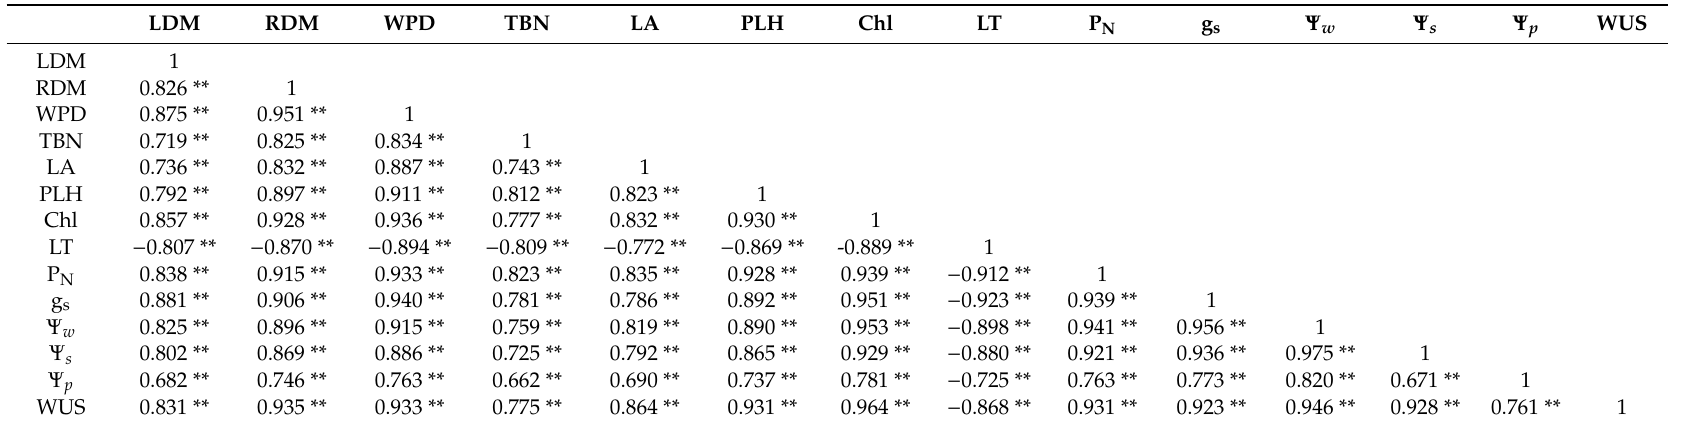
**: di ff erences between traits are significant at p < 0.01. LDM = leaf dry mass; RDM = root dry mass; WPD = whole-plant dry mass; TBN = tuber number; LA = leaf area; PLH = plant height; Chl = leaf chlorophyll; LT = leaf temperature; P N = net photosynthesis; g s = stomatal conductance; Ψ w = leaf water potential; Ψ s = leaf osmotic potential; Ψ p = leaf turgor; WUS = water